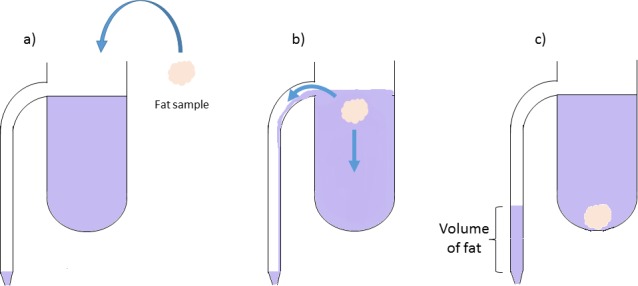
Scheme of the use of the density meter.The density meter comprises a graduated tube connected to a tank, filled with an inert liquid (kerosene) (43,44). (a) A sample of mouse fat is weighed and placed slowly in the tank. (b) The fat sample overflows the kerosene that falls into the graduated tube. (c) The volume of kerosene (mL ± 0.05mL) that has flowed into the graduated tube is measured and is equal to the volume of fat.